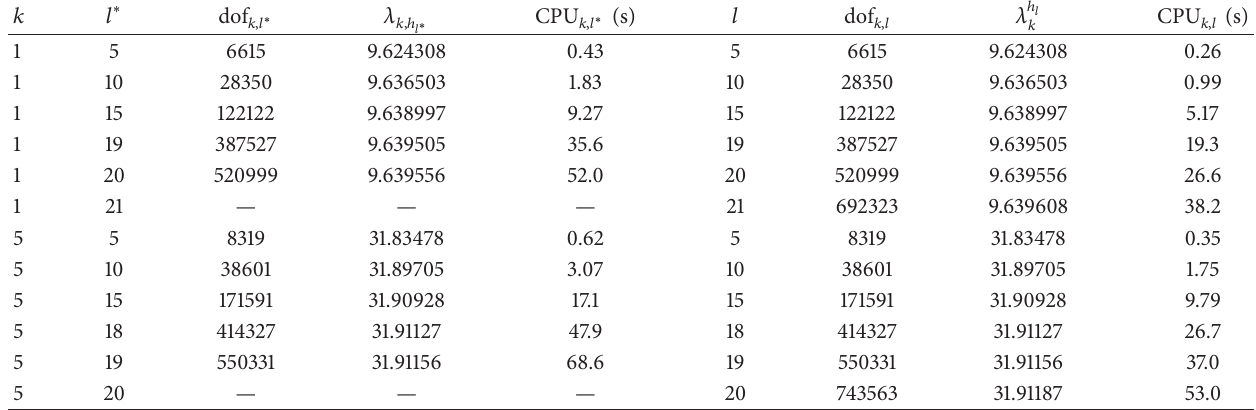
Table 1: The 1st and 5th eigenvalues obtained by two algorithms on 𝐿 -shaped domain with 𝐻 = √2/16 .